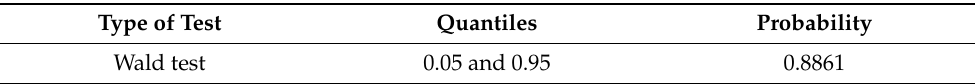
Table 4. Test of equality of coefficients at different quantiles.